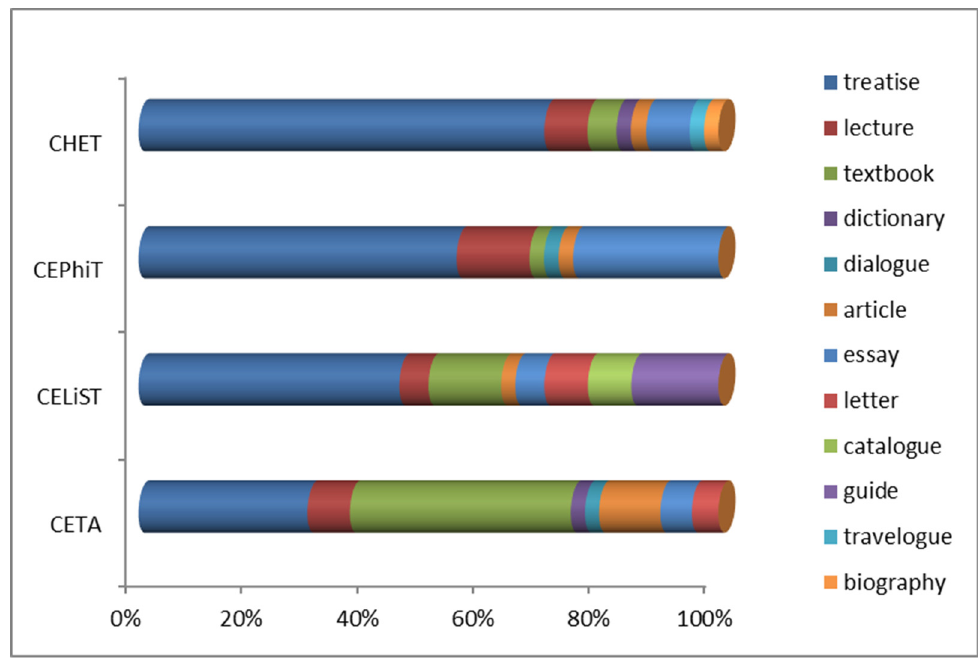
Figure 2. Words per genre.